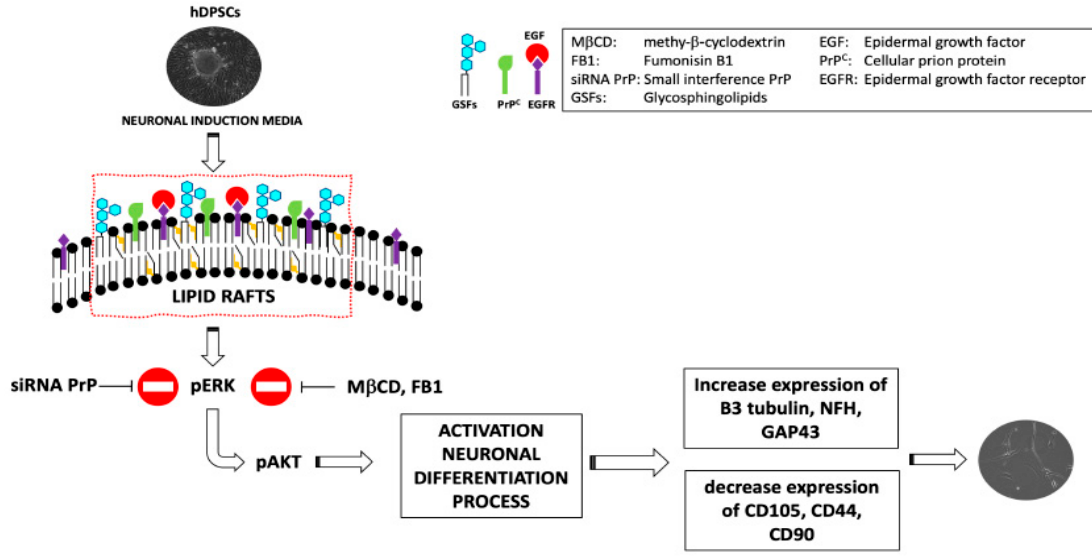
Figure 1. Role of lipid raft inhibitors and siRNA PrP in the neurodifferentiation process of hDPSCs.